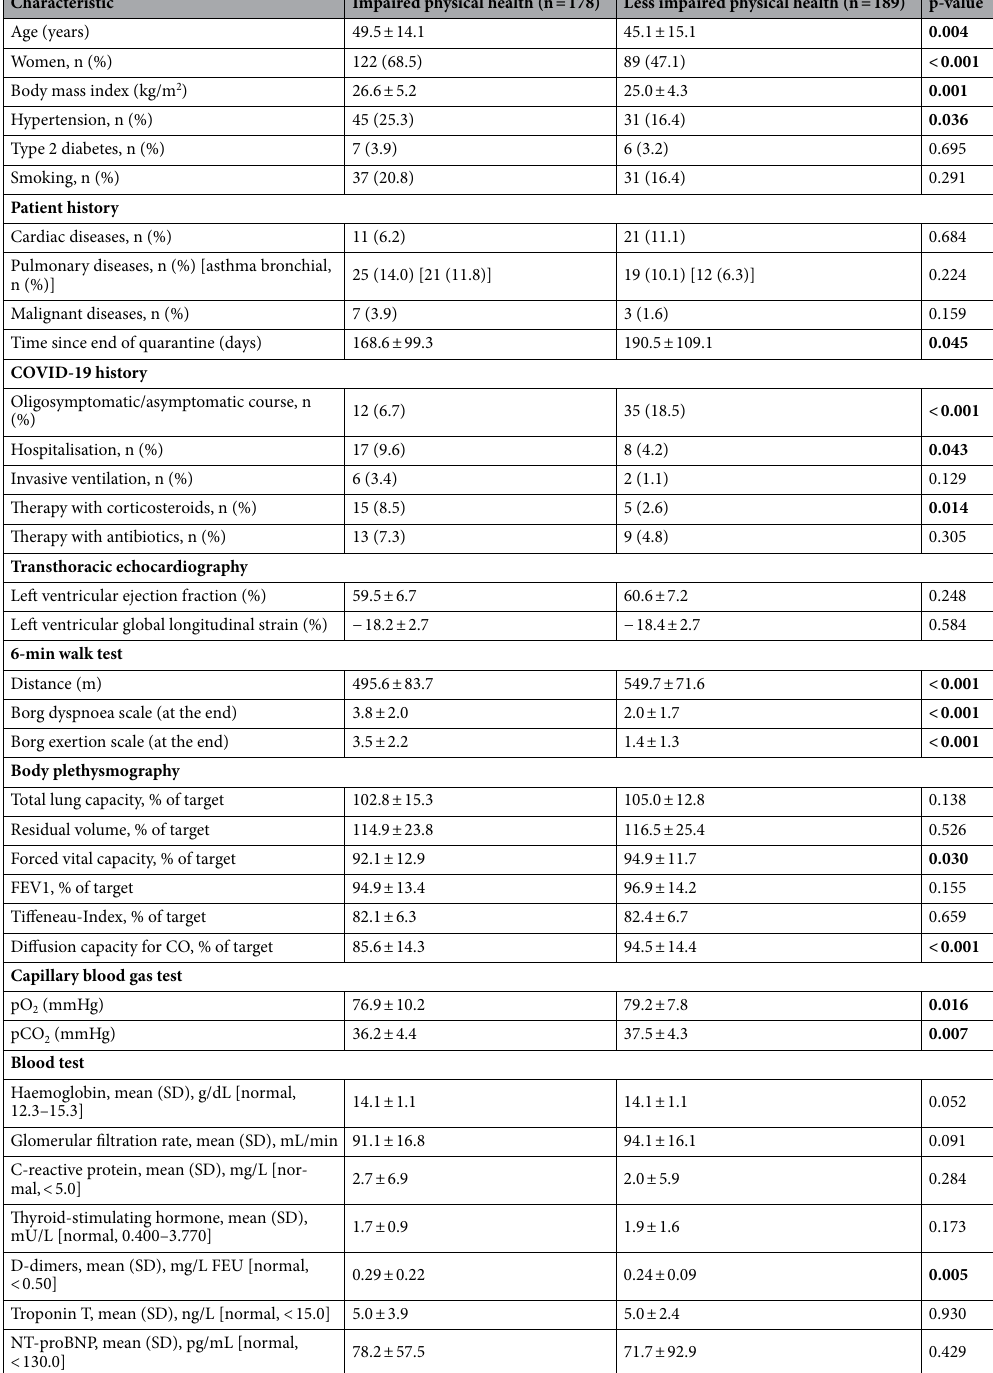
Table 3. Cardiac and pulmonary function depending on the assessment of physical health by the SF-36 questionnaire. The lower two quartiles (< 70.6 points) were described as impaired, and the upper two quartiles (> 70.6 points) as less impaired physical health. Continuous variables are expressed as means ± standard deviations. Categorical variables are expressed as numbers (percentages). FEV1 forced expiratory volume in one second, CO carbon monoxide, FEU fibrinogen-equivalent units, NT-proBNP N-terminal pro b-type natriuretic peptide. Significant values are in